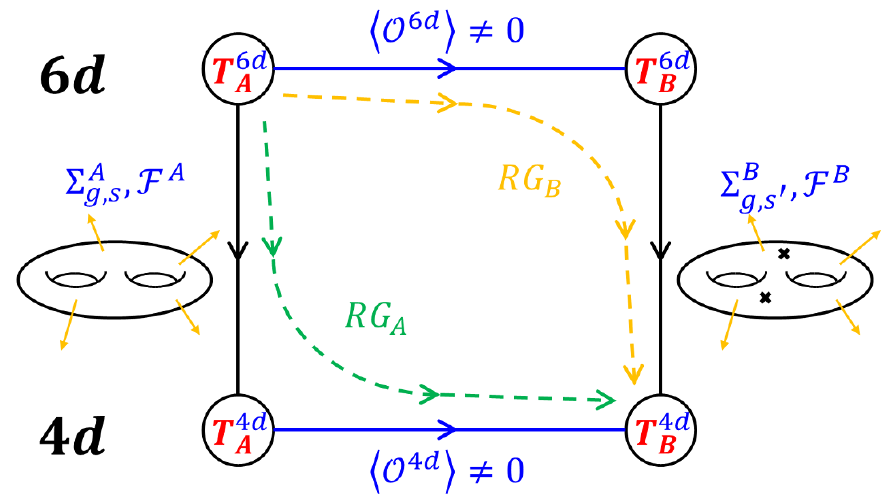
Figure 14 . A diagram representing the di(cid:11)erent RG (cid:13)ows that we can consider. Flow RG A describes a compacti(cid:12)cation of a 6 d model to an e(cid:11)ective 4 d theory followed by a vev to an operator in 4 d . Flow RG B is de(cid:12)ned by (cid:12)rst turning the vev to a 6 d operator and then compactifying the model to 4 d